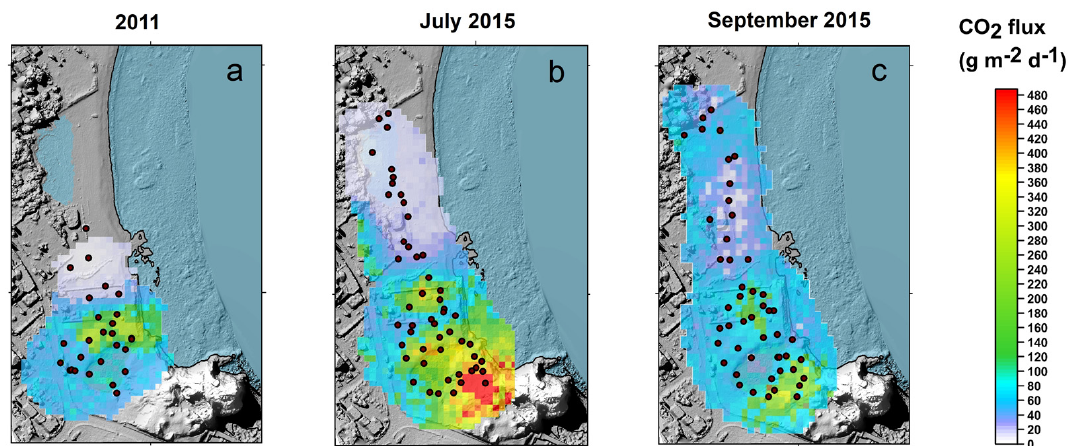
Figure 8. Maps of CO 2 diffuse flux derived from interpolation of the measurements made in the Baia di Levante in different periods: ( a ) May 2011; ( b ) July 2015; ( c ) September 2015.